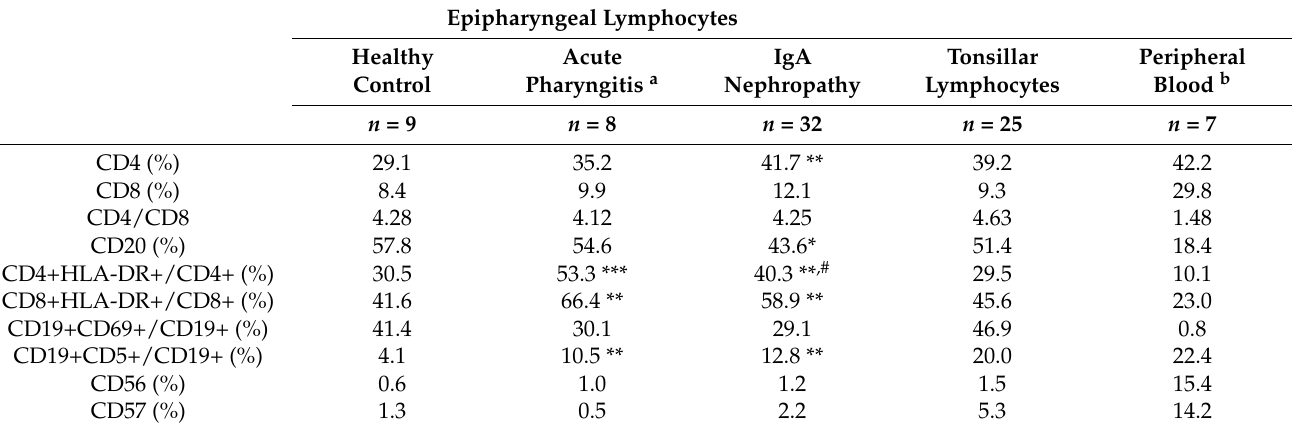
Table 1. Phenotypic features of epipharyngeal lymphocytes. Epipharyngeal Lymphocytes Healthy Acute Control Pharyngitis